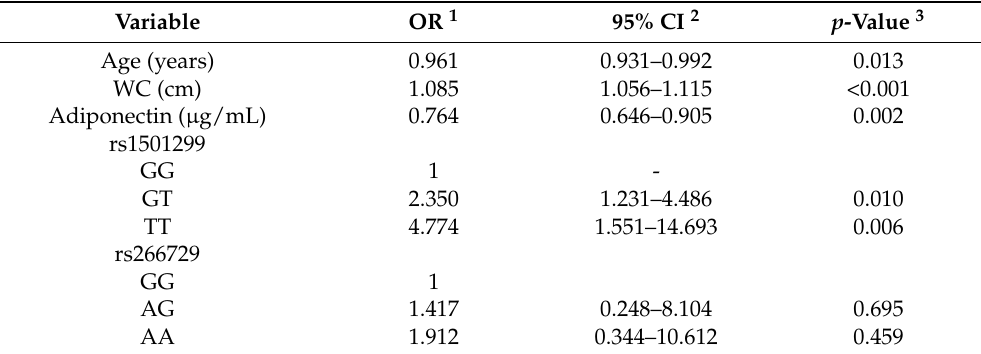
Table 6. Multivariate regression analysis of study